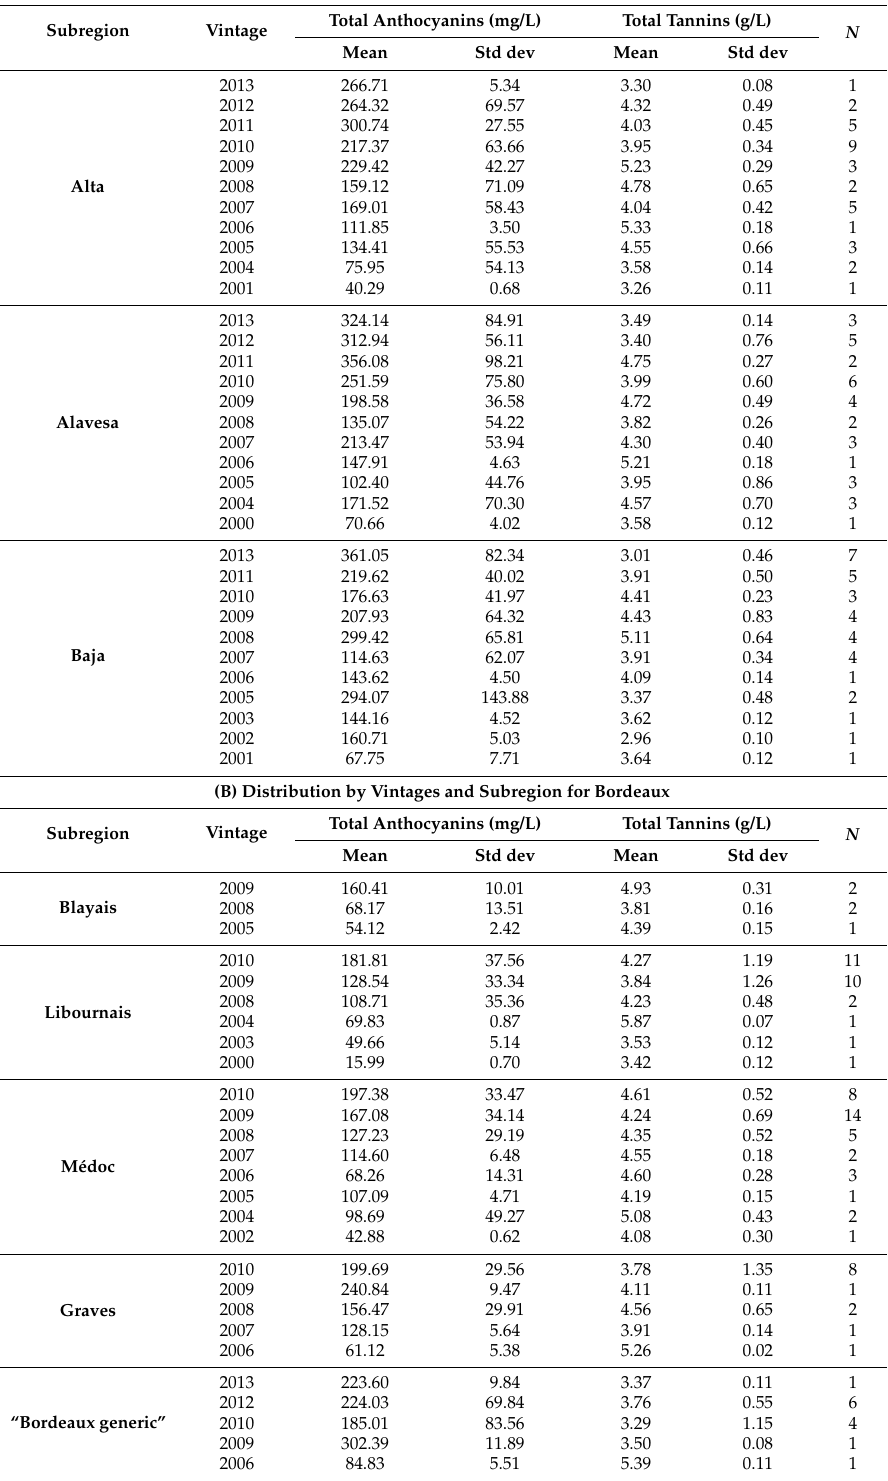
Table 2. Total anthocyanin and tannin contents distributed by subregion and vintages ( A ) Rioja subregion ( B ) Bordeaux